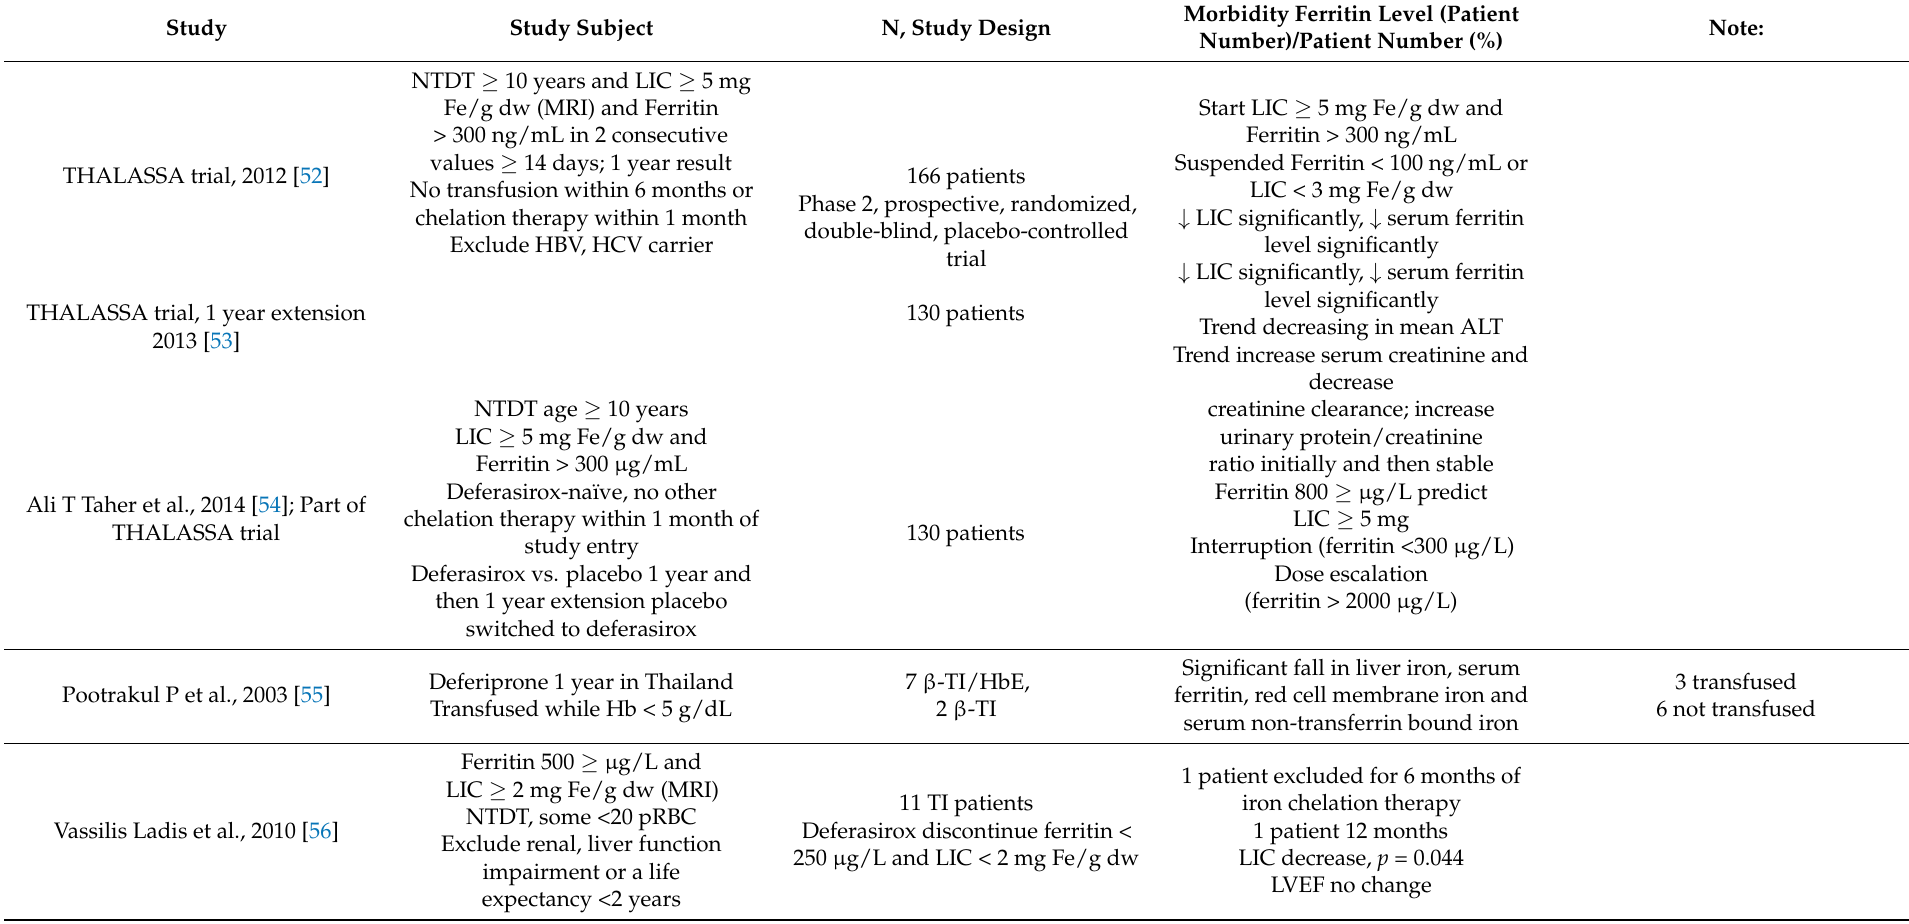
Table 5. Decreased ferritin, but do not mention